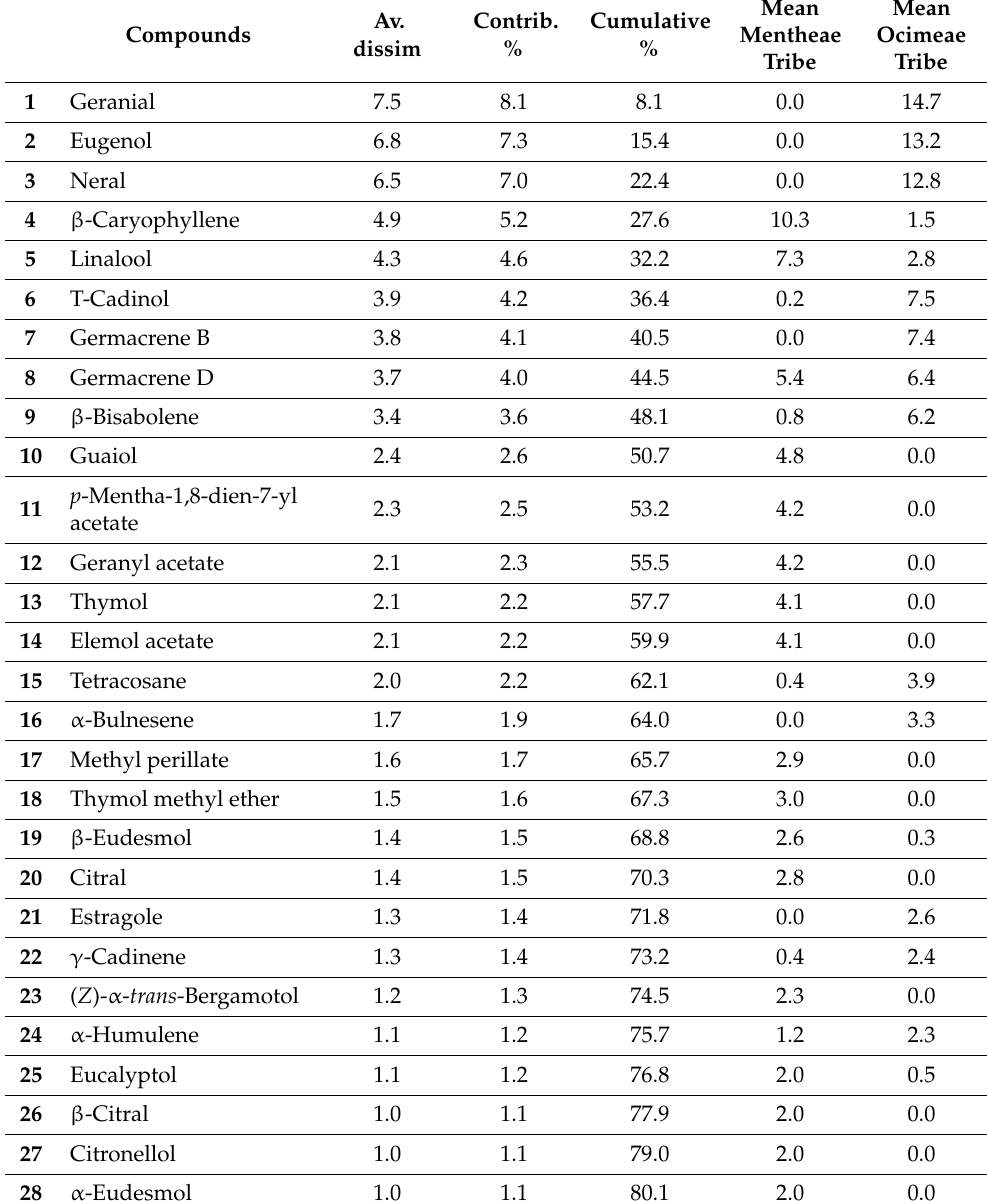
Table 6. SIMPER analyses test on subtribe ( A2 ) and tribe ( B2 ) dissimilarity performed in essential oils